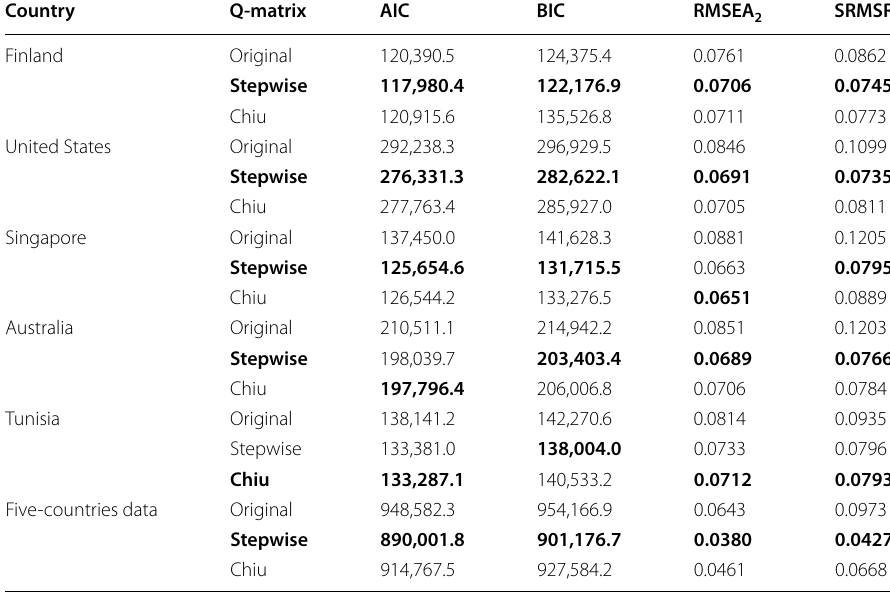
Table 3 Results of G-DINA Model